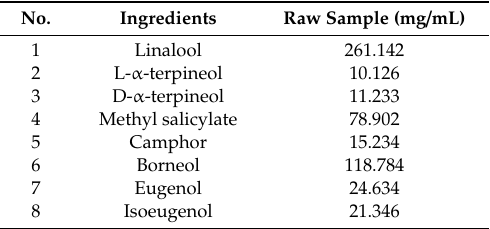
Table 2. Contents of main components of essential oil in Paederia scandens